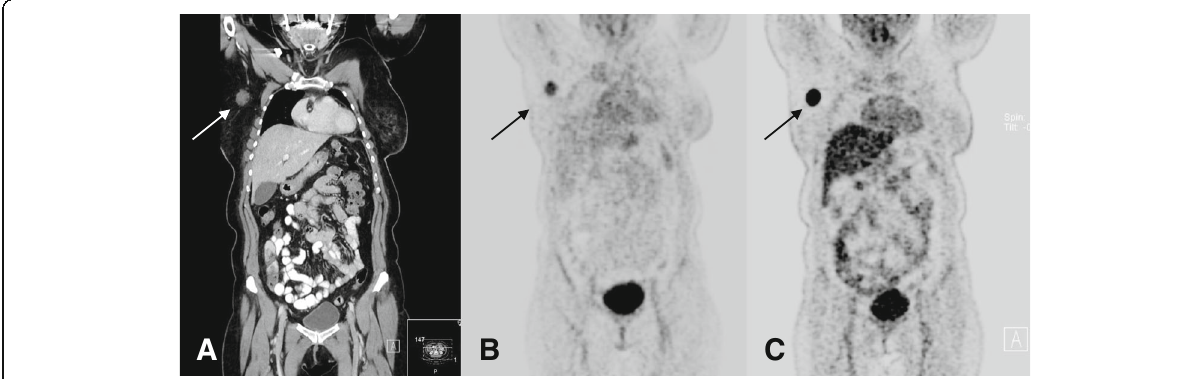
Fig. 2 67-year-old patient with a nodal recurrence 22 months after treatment of a primary breast cancer. Coronal CT reconstruction shows a contrast enhancing lymph node metastasis with a diameter of 2.1 cm in the right axillary region ( a ). The lesion is visually detectable on 68 Ga- Pentixafor PET with a corresponding SUVmax of 4.0 ( b ). On 18 F-FDG PET/CT, the lesion shows a significantly higher tracer uptake (SUVmax of 24.4) ( c